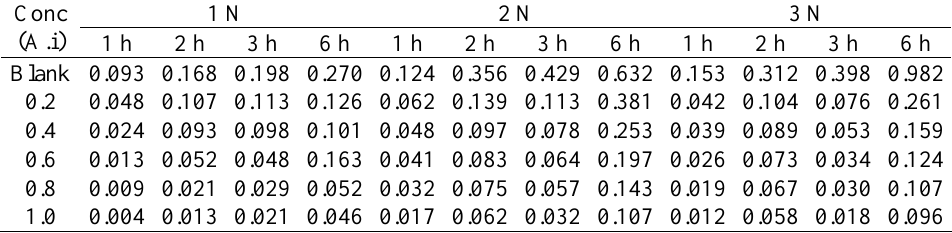
Table 1. Weight loss as the function of exposure time on copper metal in different normality of HNO using Azadirachta indica seed extract at room temperature 3